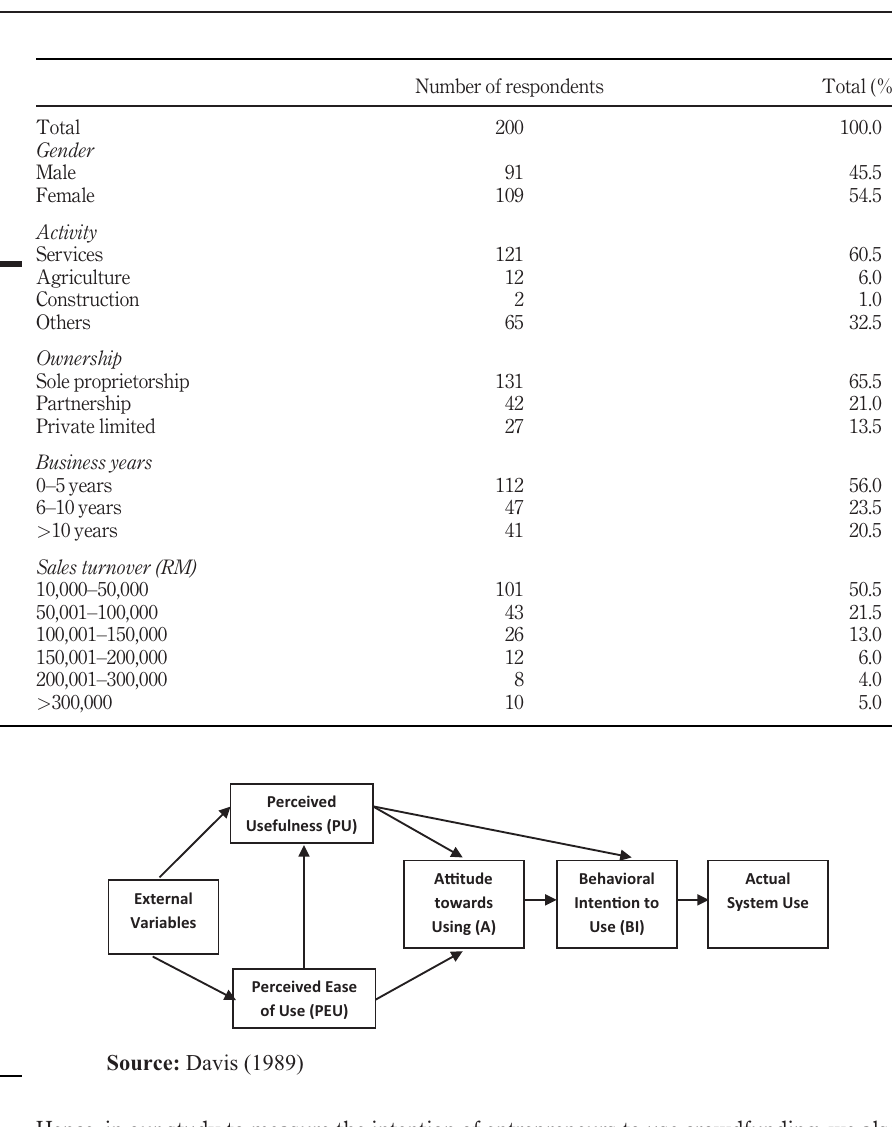
Source: Davis (1989)